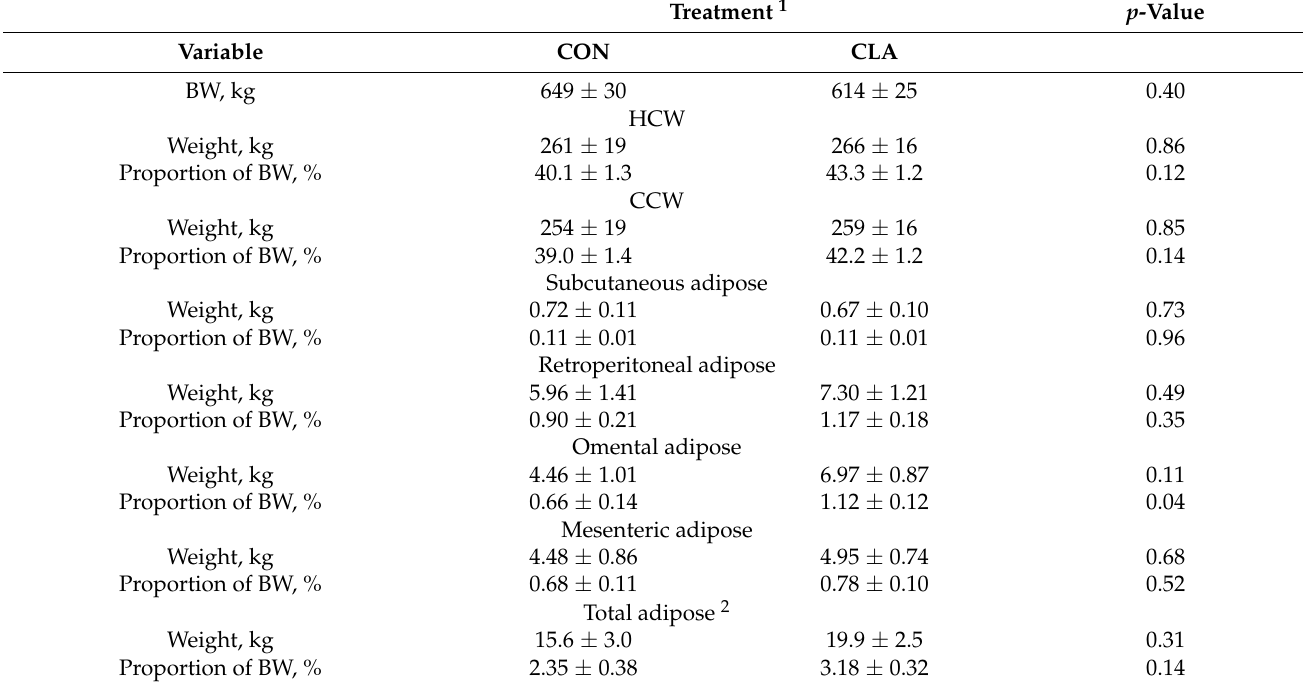
Table 2. Body weight (BW), hot carcass weight (HCW), cold carcass weight (CCW), adipose depot weights, and their proportion of BW at slaughtering at wk 9 postpartum for cows daily abomasally supplemented either with coconut oil (CON; n = 5) or conjugated linoleic acid (CLA; n = 5) from d 63 antepartum until slaughter on d 63